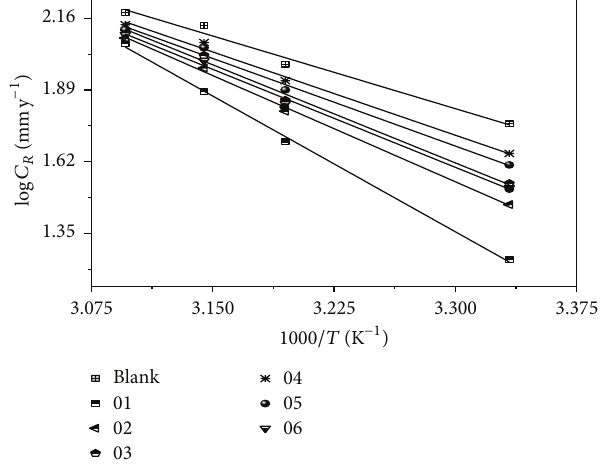
Figure 2: Arrhenius plots of log 𝐶 𝑅 versus 1/𝑇 for mild steel in 1N H 2 SO 4 in the absence and presence of inhibitors(01–06) at optimum concentration (0.4 × 10 −3 M).